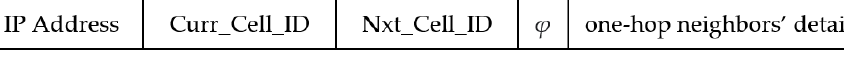
Figure 6. Hello message format.